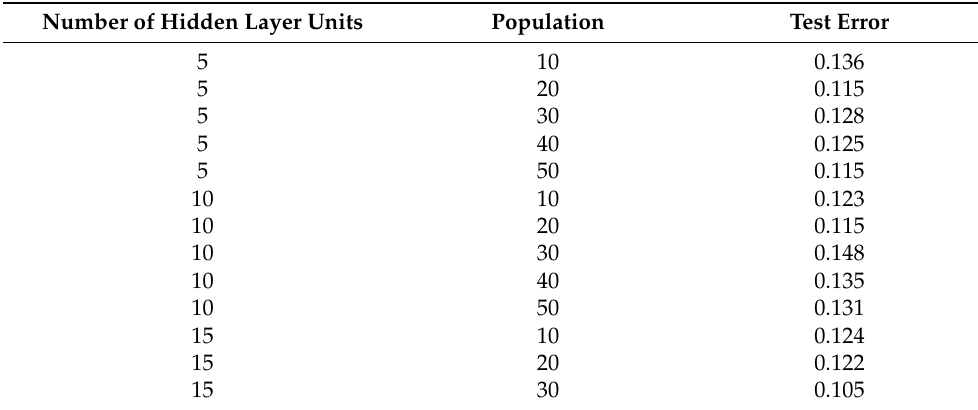
Table 3. The errors of selecting different